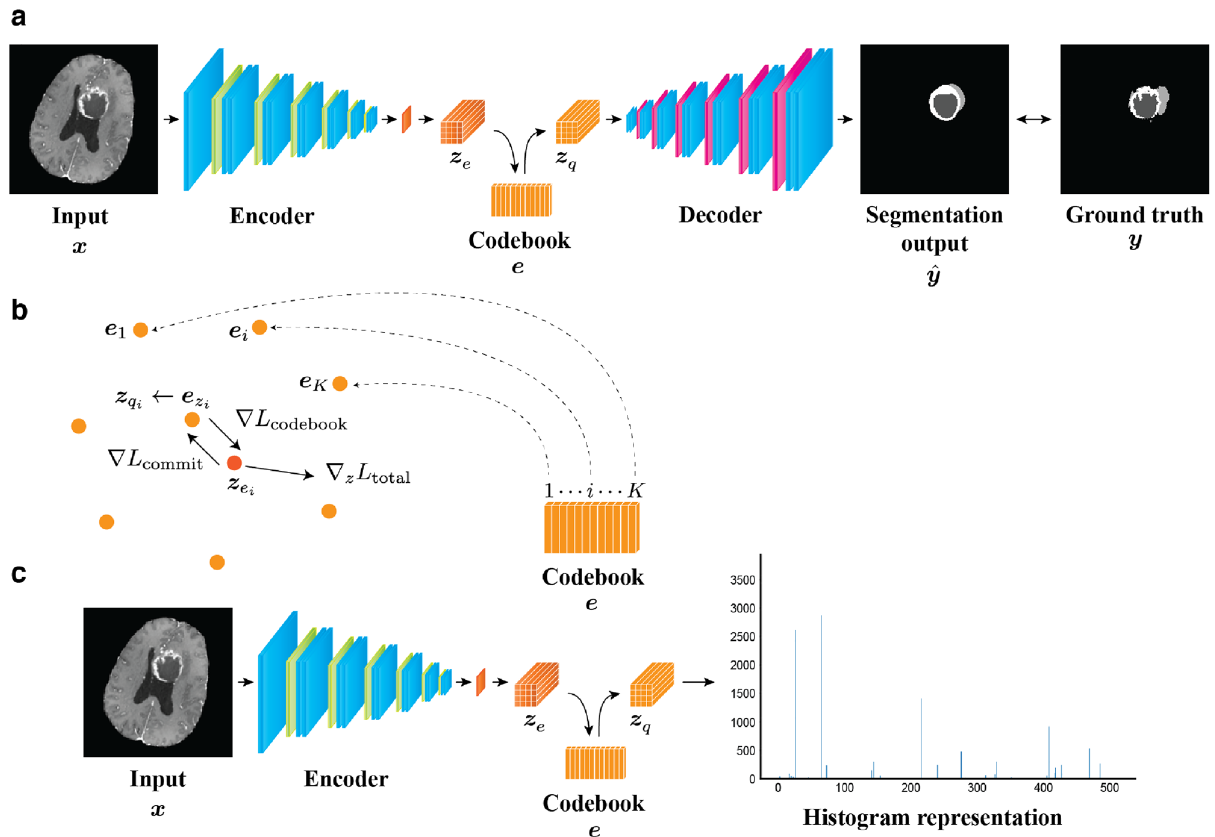
Figure 1. Obtaining a shareable set of feature vectors from a segmentation network. ( a ) A segmentation network consists of an encoder–decoder pair and stores a shareable set of feature vectors in a codebook. At the training stage of a tumor segmentation pre-task, an input image x is mapped onto a latent representation z e through the encoder. Vector quantization is performed based on the codebook e by replacing each feature vector in z e with the nearest codeword to produce a quantized latent representation z q . Then, the decoder produces a segmentation output by taking z q as the input. The error between the segmentation output and a ground- truth label is evaluated to train the network. ( b ) During the training, the codebook loss ∇ L codebook enforces the codebook variables toward the encoder’s output, meanwhile the commitment loss ∇ L commit exerts the opposite effect. To alter the configuration of the codebook, the encoder’s output is updated for the next forward pass according to the learning objective ∇ z L total . ( c ) When using the shareable set of feature vectors in a downstream task, the encoder is employed as a feature extractor. The latent representation of an input image is mapped onto the quantized latent representation z q , and then a histogram representation is constructed. This histogram representation contains information on the frequency with which each feature vector appears in the input